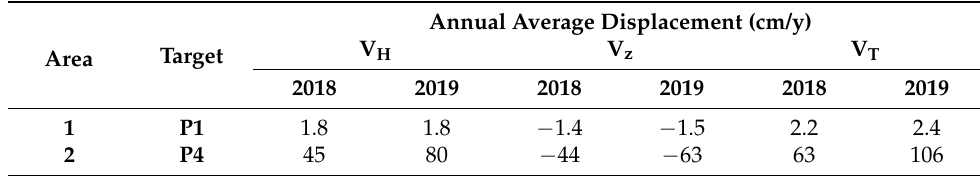
Figure 4. Distribution of surficial displacements of Sant’Andrea landslide, identified in the time span from February 2019 to February 2020 obtained from monitoring of topographic targets [37]. The vectors represent the horizontal displacements while the contours refer to the value of total displacements. Table 2. Displacement rates in 2018 and 2019 for two reference targets P1 and P4, where V H , V Z and V T state for horizontal, vertical and total displacement rates,